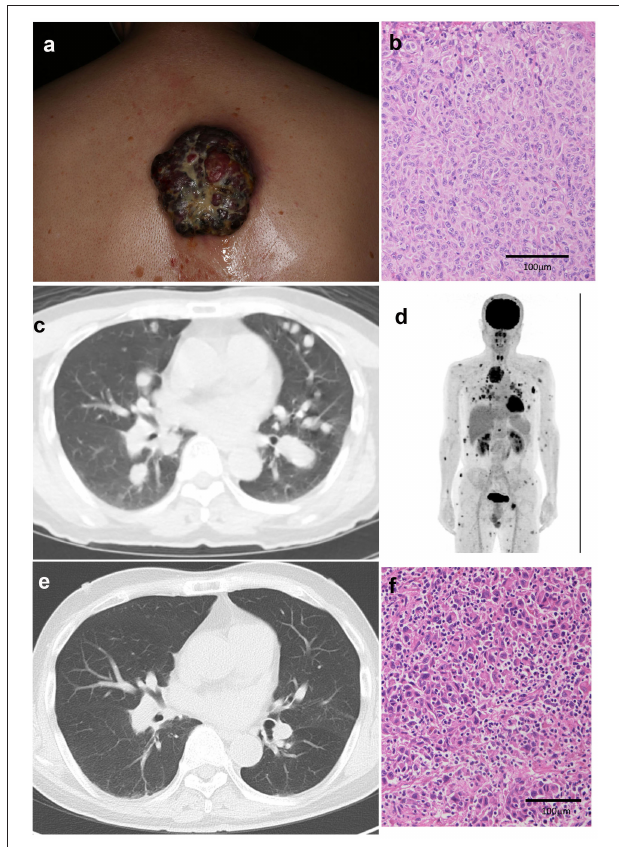
FIGURE 1 | A black nodule (8 × 7cm) with a dark-red nodule on the back (a) . Histological findings of the primary tumor before treatment: markedly atypical melanocytes arranged in irregular nests and solitary units (b) . Multiple lung metastases (c) , cutaneous, pharyngeal, and peritoneal nodules, lymph node metastases, and bone metastases on PET-CT (d) . After treatment, multiple lung metastases are decreased (e) . Histological findings of the primary tumor after single administration of nivolumab with ipilimumab showing dense infiltration of lymphocytes in the melanoma lesion (f)